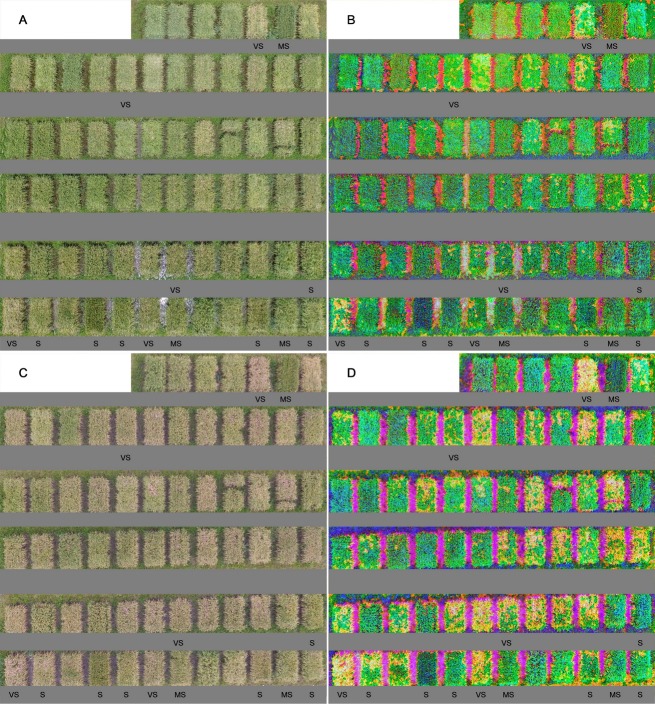
Original RGB and HLS transformation images of 67 field plots on Aug 23rd
(A and B) and Aug 30th(C and D). The ratings of resistance to ShB with very susceptible (VS), susceptible (S), and moderately susceptible (MS) were indicated in selected plots (cultivars or lines).